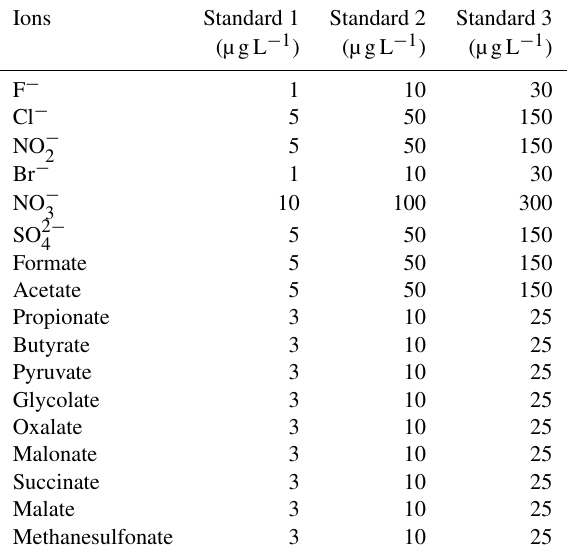
Table 1. Aqueous standard solution concentrations used for the cal- ibration of the Compact